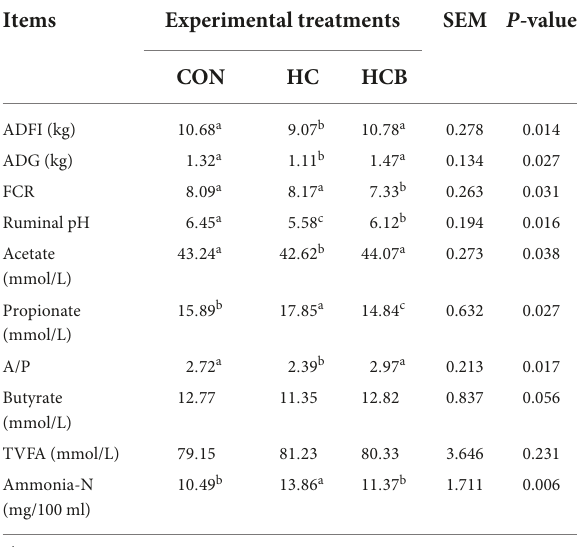
TABLE 3 Effects of high-concentrate diet and thiamine supplementation feeding treatments on production and ruminal fermentability parameters ( n =